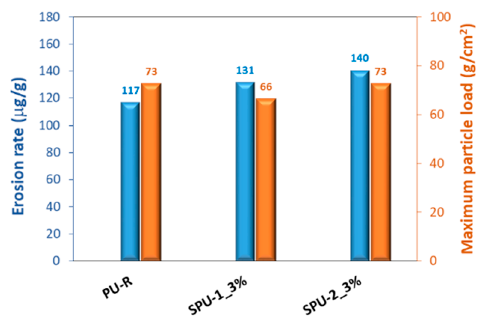
Figure 6. Sand erosion resistance of PU-R and SPU coatings. Test conditions: 50 µ m angular alumina particles, impact velocity of 150 m/s, impact angle of 30°.